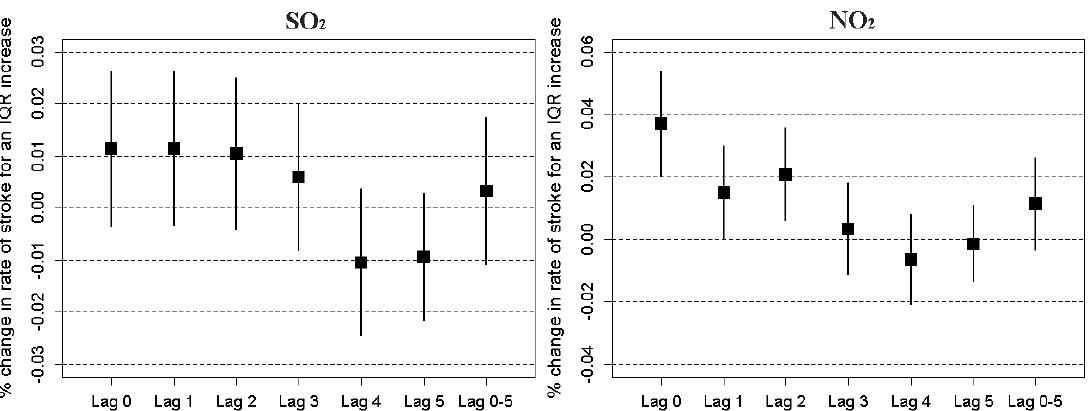
Figure 3. Percent change in ischemic stroke risk associated with an inter quartile range (IQR) increase in the level of NO 2 (IQR = 26 µ g/m 3 ) and SO 2 (IQR = 10 µ g/m 3 ), respectively.